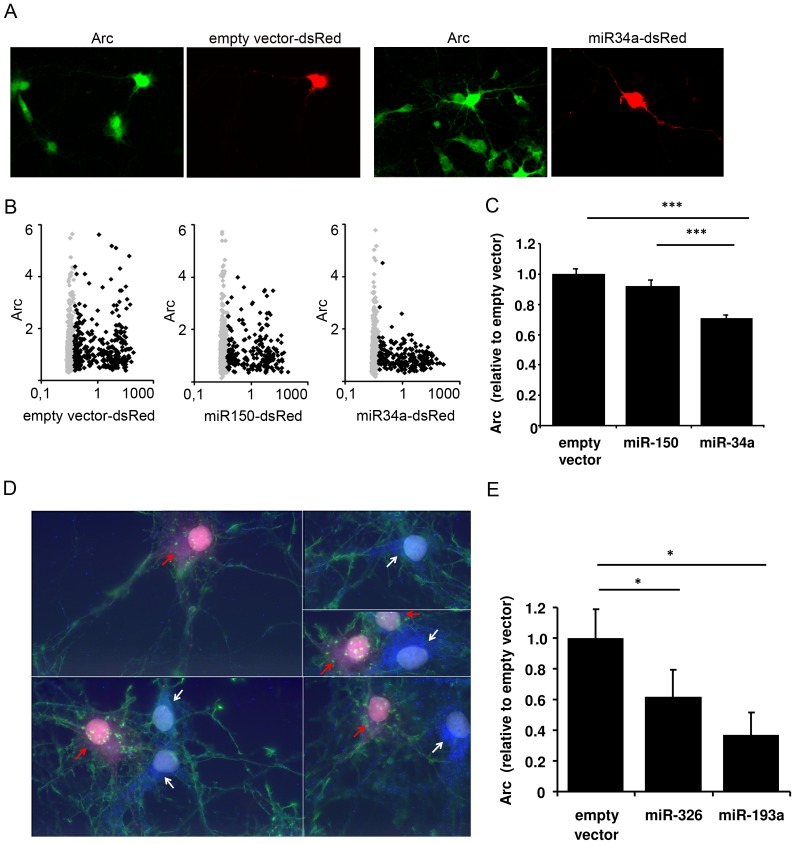
miR-34a, miR-326 and miR-193a downregulate Arc protein expression in cultured hippocampal neurons.Cultured hippocampal neurons were transfected with either empty vector-DsRed, miR150-DsRed, miR34a-DsRed, miR326-DsRed or miR193a-DsRed. Neurons were treated with BDNF for four hours and Arc protein expression was assessed by light microscopy. A) representative images of cells transfected with empty vector-DsRed and miR34a-DsRed, respectively. Note that Arc levels are very diverse within one sample. The fields of view were chosen to contain at least one DsRed-expressing neuron per image, and approximately 60 images from at least two different coverslips were taken per condition per experiment. During image acquisition and subsequent data analysis, the experimenter was blinded to the treatment group of the cells. B) scatter plots of Arc vs. DsRed levels per cell. Data are normalized to the average value of non-transfected cells. Gray diamonds = non-transfected cells; black diamonds = transfected cells. n = 3996 cells from 3 experiments. C) bar graph comparing the average Arc level in transfected cells. Values are normalized to the average Arc level in the non-transfected cells. A significant downregulation of Arc protein was seen in miR-34a transfected cells. Significance was tested by independent t-tests, p<0.001. Error bars = SEM. n = 763 cells from 3 experiments. D) representative images of cells transfected with miR-326-DsRed (cells labelled with DsRed and red arrows) and non-transfected cells (white arrows). Immunostaining of Arc protein is visualized in blue. Note that Arc levels are very diverse within one sample. Phalloidin labelling in green was used to visualize the individual cells. E) bar graph comparing the average Arc level in transfected cells. Values are normalized to the average Arc level in the non-transfected cells. A significant downregulation of Arc protein was seen in miR-193a and miR-326 transfected cells. Significance was tested by univariate ANOVA and post hoc tests, p<0.05. Error bars = SEM. n = 339 cells from 3 experiments.